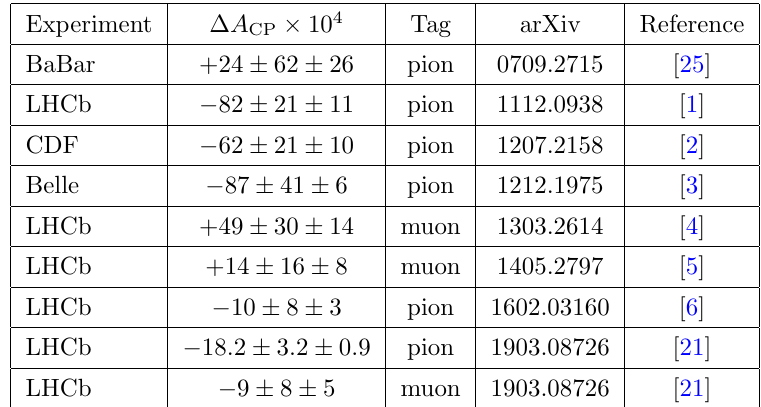
Table 1 . Time evolution of CP violation in the charm